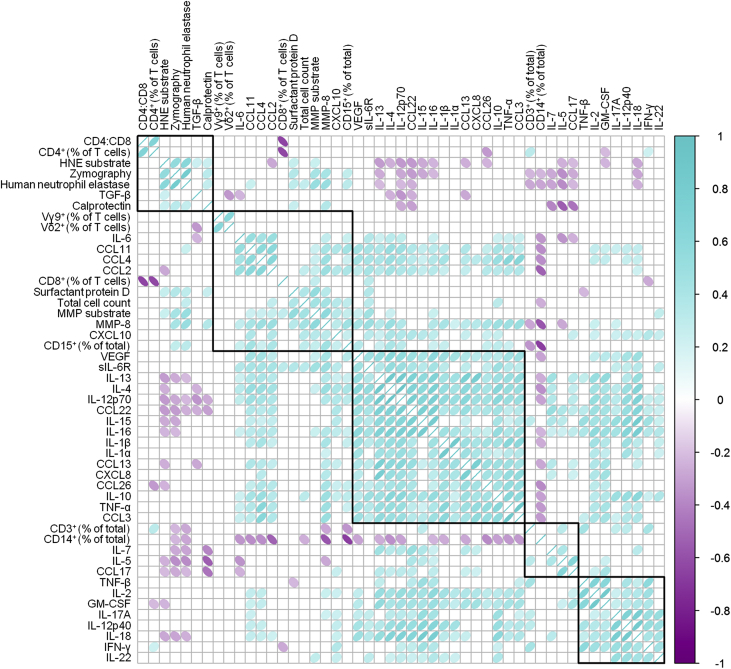
Correlation analysis of local biomarkers in a total of 83 peritoneal dialysis patients on the day of presentation with acute peritonitis. Ellipses depict the correlation coefficients for each pair of biomarkers in the corresponding cell of the matrix, with the direction of the dip and the color of the shading representing positive and negative correlations, respectively. Only pairs with significant correlations (P < 0.05) are shown. Analyses were performed using the corrplot R and Hmisc R packages. GM-CSF, granulocyte macrophage colony-stimulating factor; HNE, human neutrophil elastase; IFN-γ, interferon-γ; IL, interleukin; MMP, matrix metalloproteinase; sIL-6R, soluble IL-6 receptor; TGF-β, transforming growth factor-β; TNF-α, tumor necrosis factor-α; VEGF, vascular endothelial growth factor.